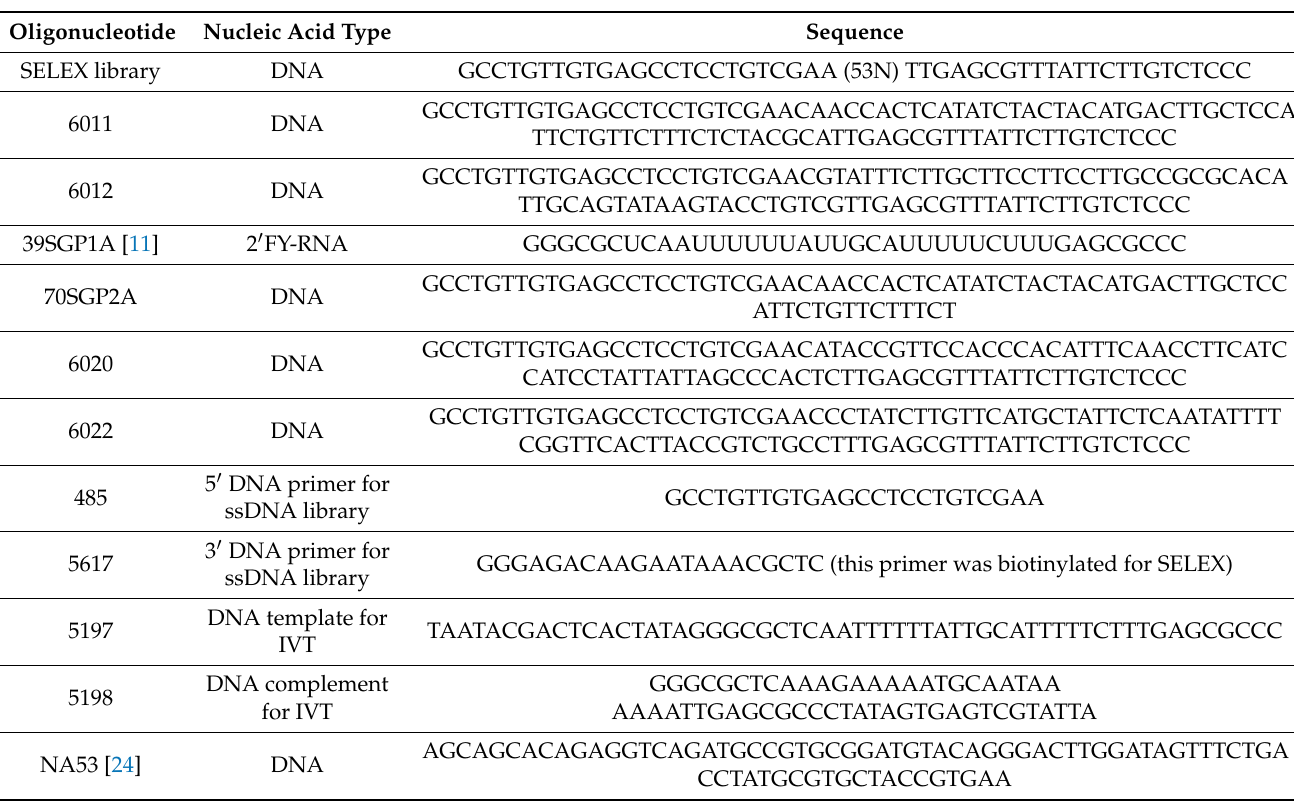
Table 2. Oligonucleotides used in this